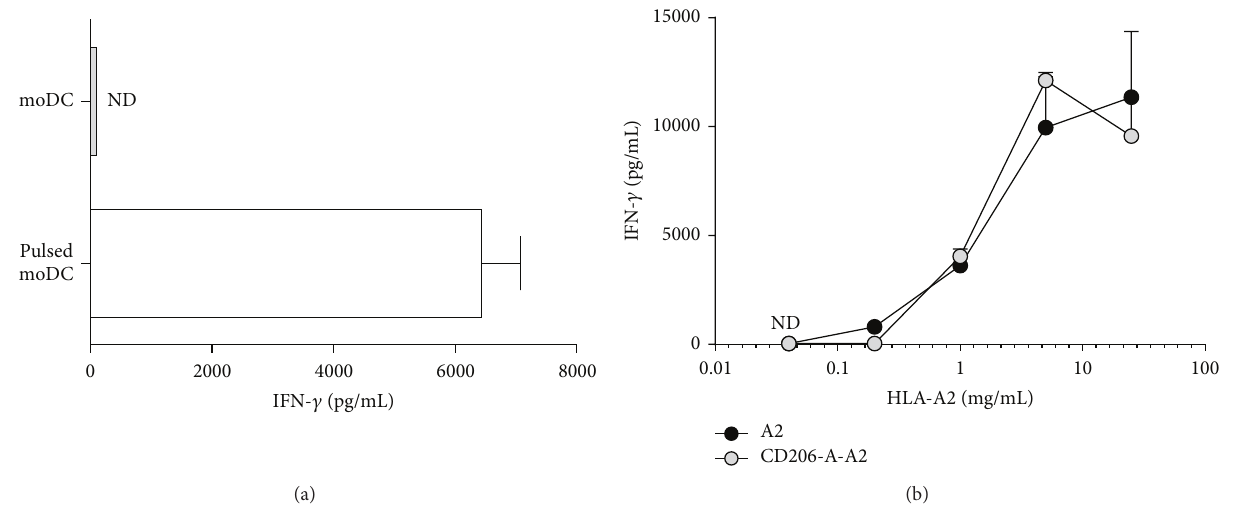
Figure 5: Antigen presentation is not improved by CD206 mediated endocytosis. (a) T-cell clone specificity was confirmed by incubating the T-cell clones with HLA-DR1+/HLA-A2 − moDCs that were either pulsed or not pulsed with HLA-A2 derived peptides. (b) DR1+/A2 − moDCs were incubated with different concentrations of monomeric HLA-A2 (A2) or the CD206-A HLA-A2 immune-complex (CD206-A-A2 ratio 3 :1). T-cells were added to the culture following 4h incubation with the antigen and subsequent washing steps. IFN- 𝛾 was measured in the supernatants after 24 h. Each experiment was conducted at least 3 times; shown is the mean of one experiment (performed in triplicate) with SD. ND: